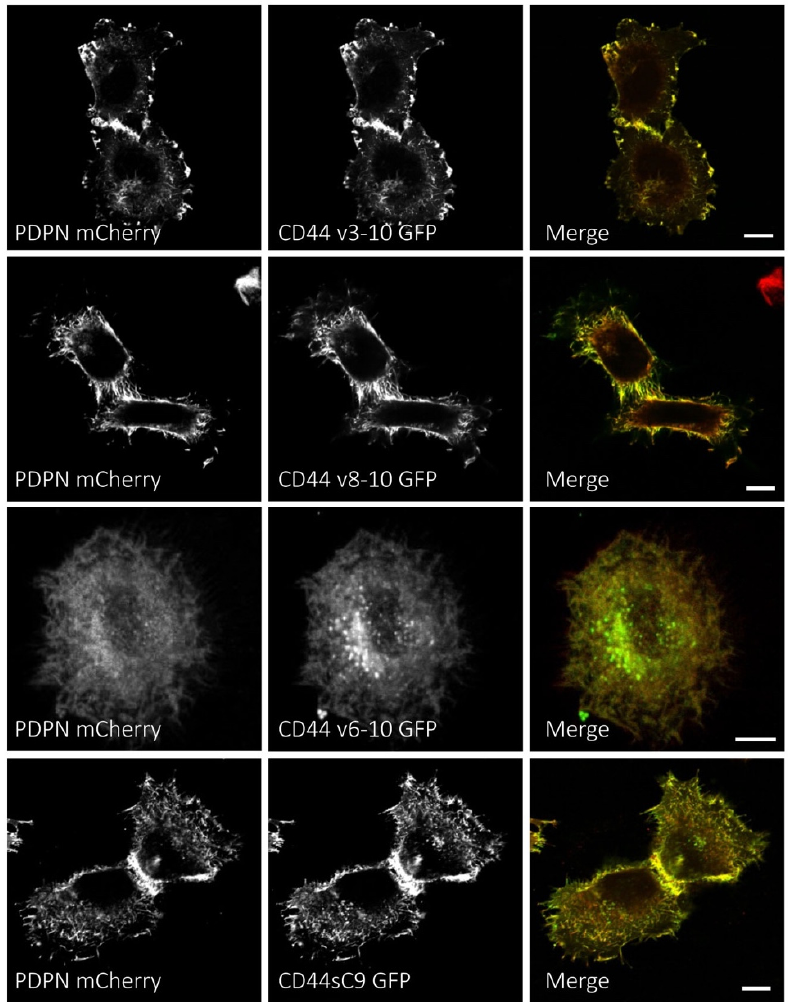
Figure 5. Colocalization of podoplanin with CD44v and CD44sC9 isoforms in SCC cells. HN5 cells were co-transfected with PDPN-mCherry and CD44v3-10-eGFP, CD44v8-10-eGFP, CD44v6-10-eGFP or CD44sC9-eGFP constructs and the subcellular distribution of the proteins studied by immunofluorescence and confocal microscopy. Grayscale images show the specific localization of each single protein while merged images are the result of GFP (green) and mCherry (red) combined images. Data represent 10–12 cells analyzed per condition from three independent experiments. Scalebar, 10 μ m.